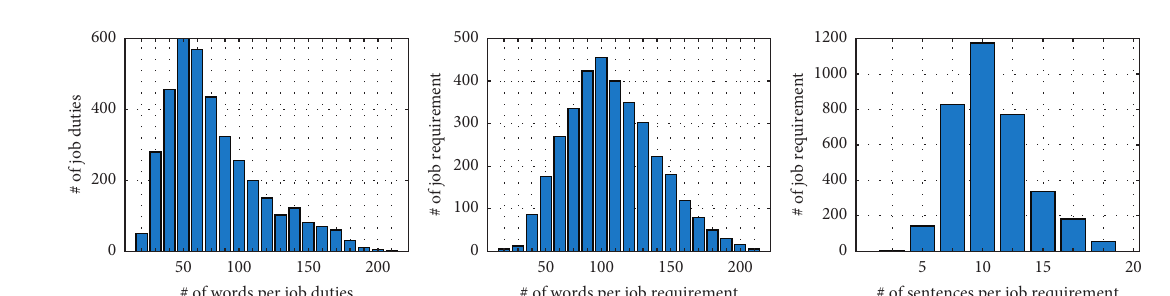
Figure 4: Text statistics of the technology ( T ) data set.